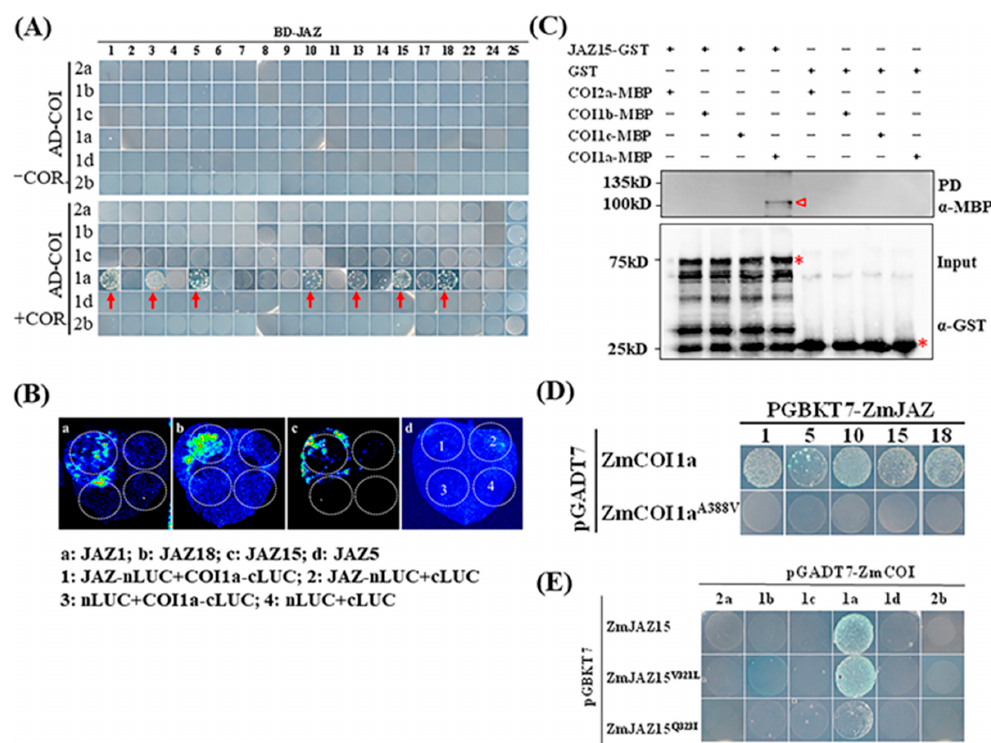
Figure 3. Interaction between COI1a and JAZ15. ( A ) Y2H assay to screen the interaction between all COIs and JAZs proteins. The top panel shows no interaction between any COI and JAZ without COR supplemented in the medium. Bottom panel shows the interaction in the medium containing 20 µ M of COR. Red arrows indicate the interaction between COI1a and JAZs. ( B ) Split-luciferase assay confirming the interactions between COI1a and selected JAZs. The panel pictures in a, b and c represent different JAZ members to be tested with COI1a, and d is the schematic diagram for different combination of the vectors. ( C ) Pull-down assay confirming the interaction between COI1a and JAZ15. The assay was conducted using 2 µ g COI-MBP and JAZ-GST fusion protein each reaction in the presence of 20 µ L GST beads, with 100 nM coronatine. The bands marked in red triangle in top panel shows the signal identified by MBP antibody, and the bands marked in red star in bottom panel shows the input of JAZ-GST fusion protein and GST protein using GST antibody. ( D ) Interaction between different ZmJAZs and ZmCOI1a point mutation in the presence of 20 µ M of COR. ( E ) ZmJAZ15 point mutants interacting with ZmCOI1a in the presence of 20 µ M of